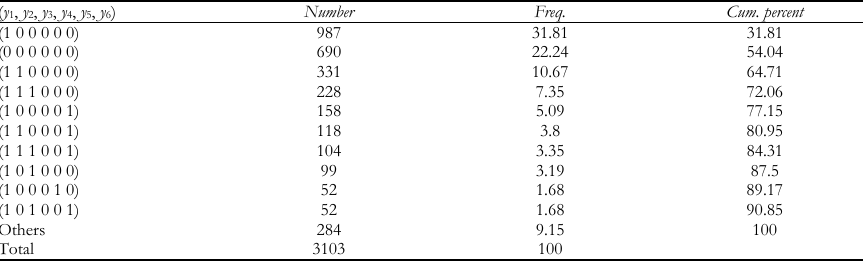
Distribution of pattern of